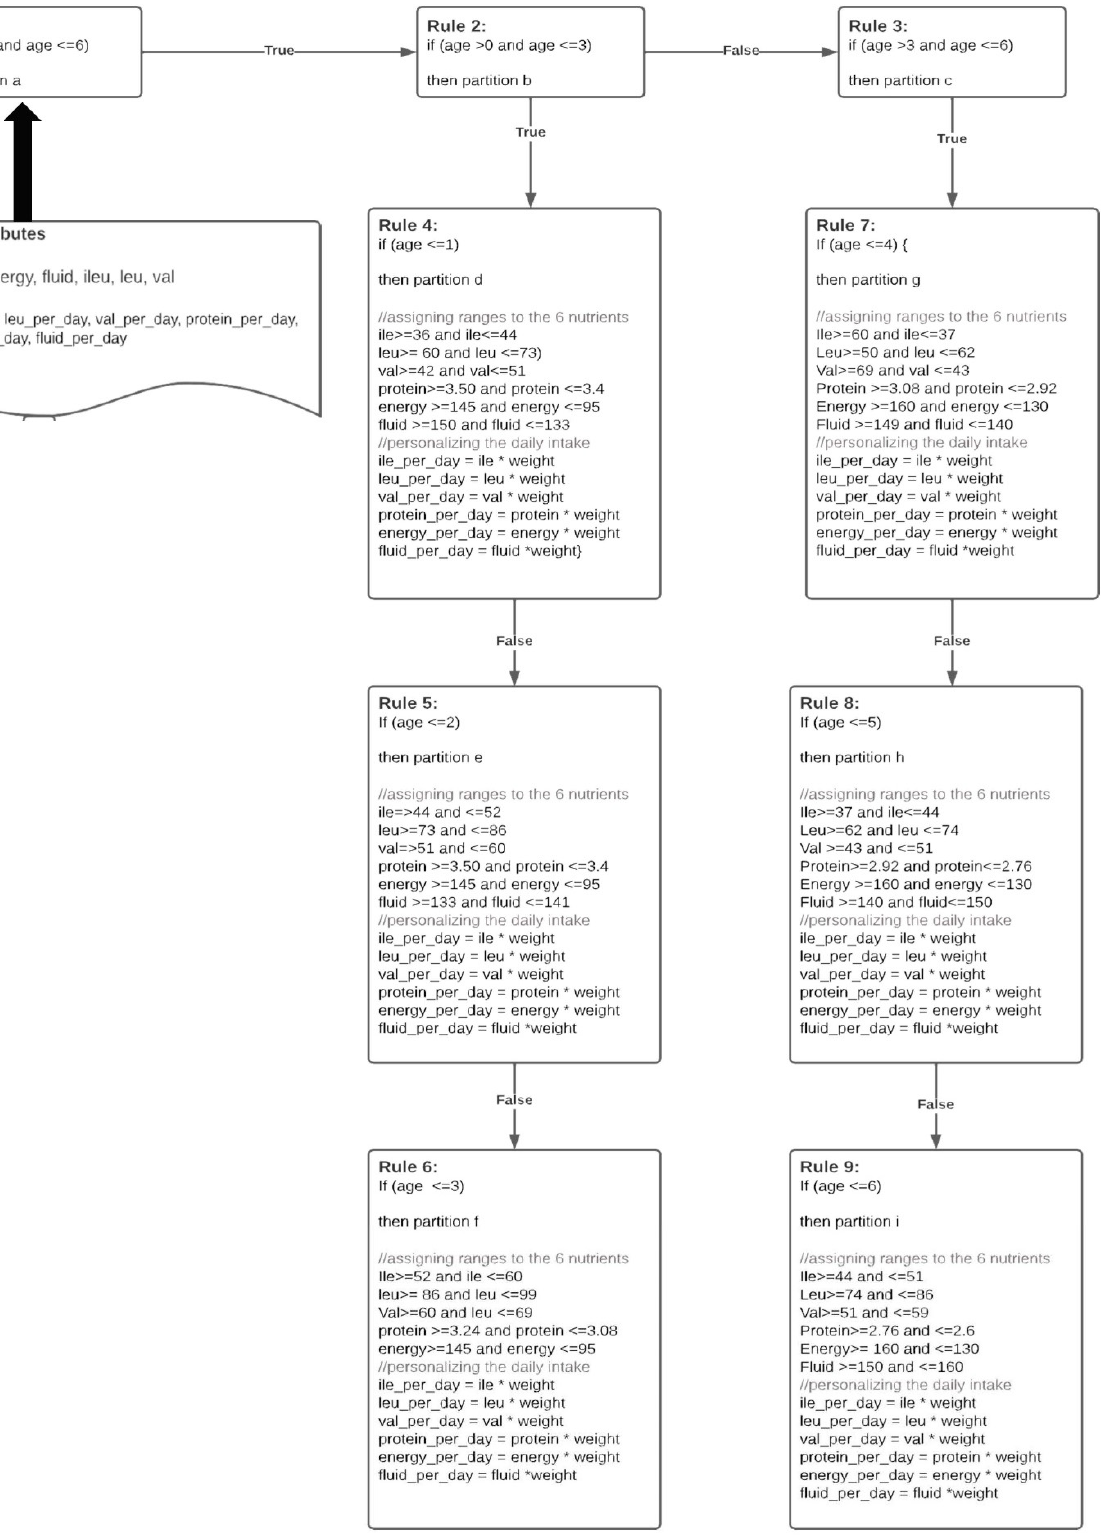
Figure 2. Knowledge acquired using RDRs [10].